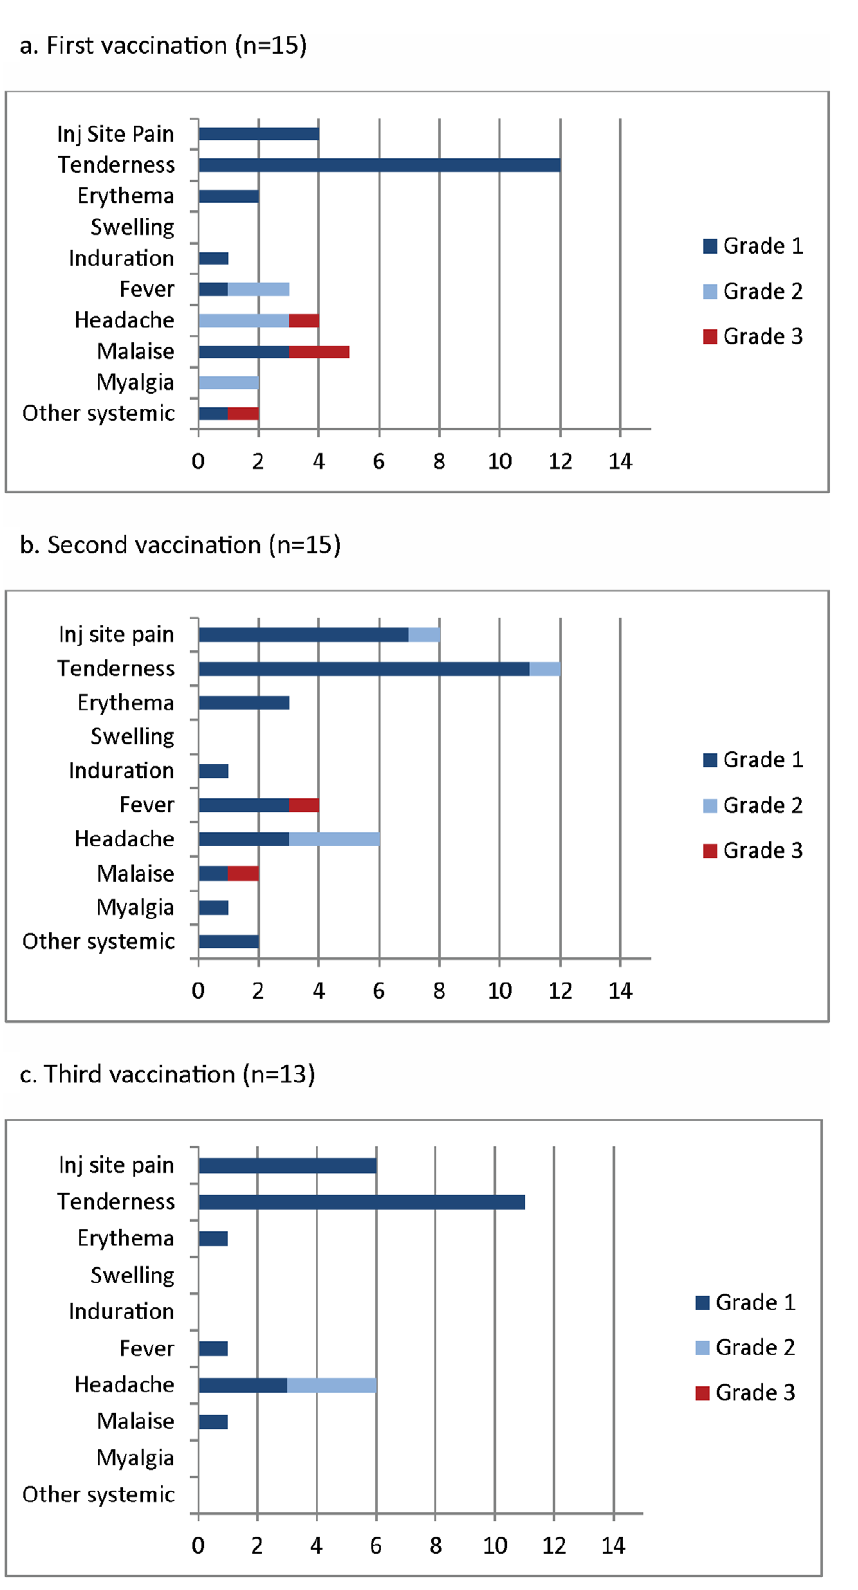
Figure 2. Local (injection site pain, tenderness, erythema, swelling, induration) and related systemic adverse events after first, second and third vaccinations in the low dose group. The x-axis shows the number of participants experiencing adverse events, with the highest severity event for each participant after each vaccination shown.